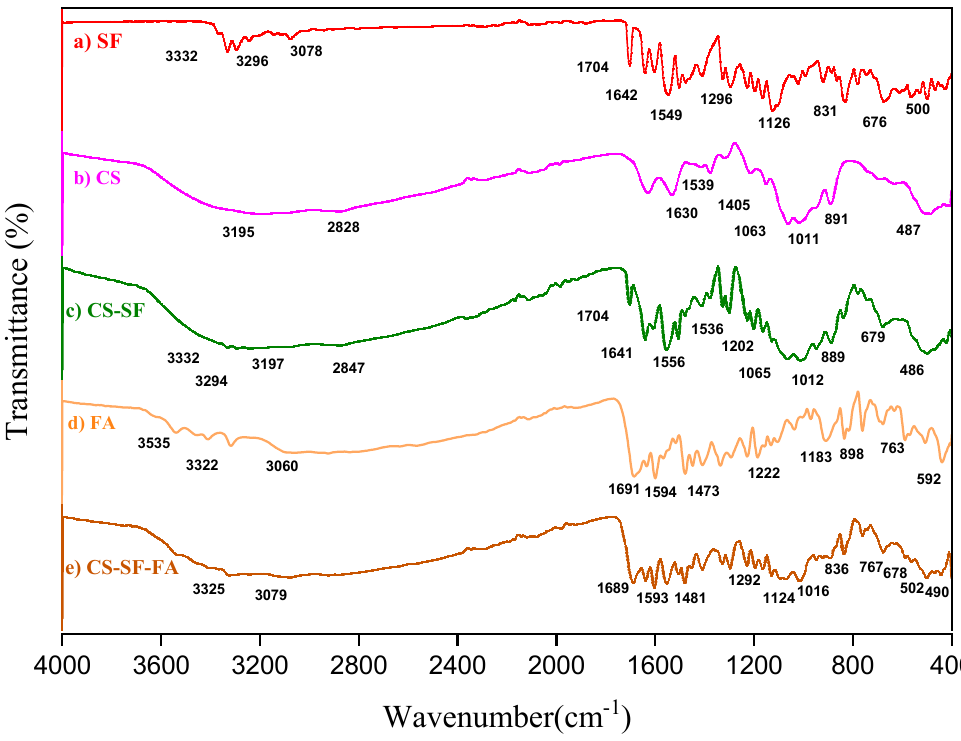
Figure 9. FTIR spectrum of SF ( a ), CS-NPs ( b ), SF-CS NPs ( c ), FA ( d ), and SF-CS-FA NPs ( e ). When SF-CS-FA nanoparticles were formed (Figure 9e), a broad absorption The FTIR spectra of free Sorafenib (Figure 9a) shows two characteristic bands at 3332 and 3296 cm − 1 due to the N-H stretching. Besides, a band at 3078 cm − 1 is related to the C- H stretching band and at 1740 cm − 1 is the characteristic band of the amide C=O group. A band at 1296 cm − 1 and 1126 cm − 1 is due to the presence of the C-O group attributed to the